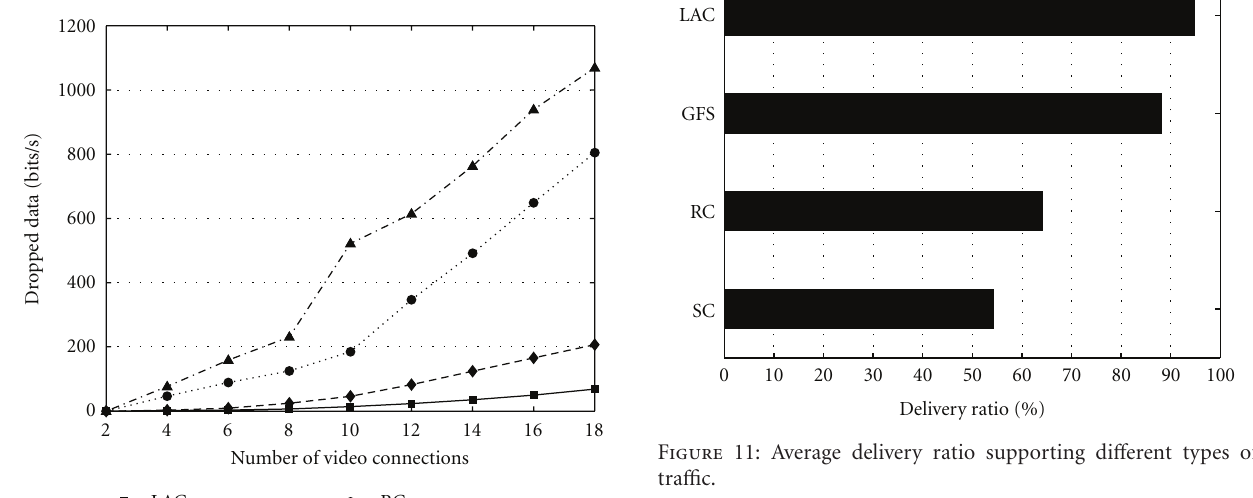
VoIP (8 connections), and video (5 connections—MPEG-4